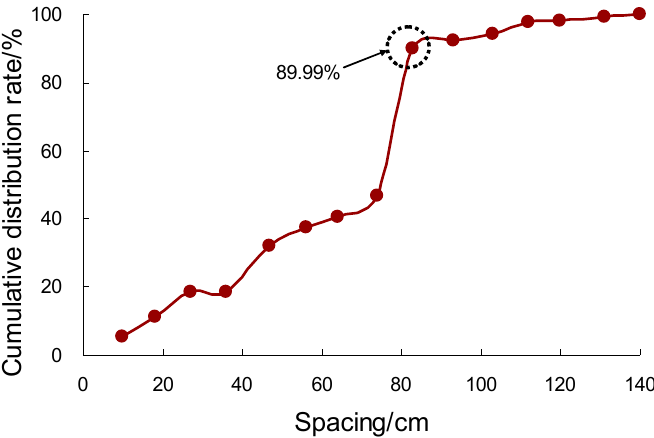
Figure 7. Cumulative distribution curve of the steep structural face spacing of red-beds’ slopes in South China.